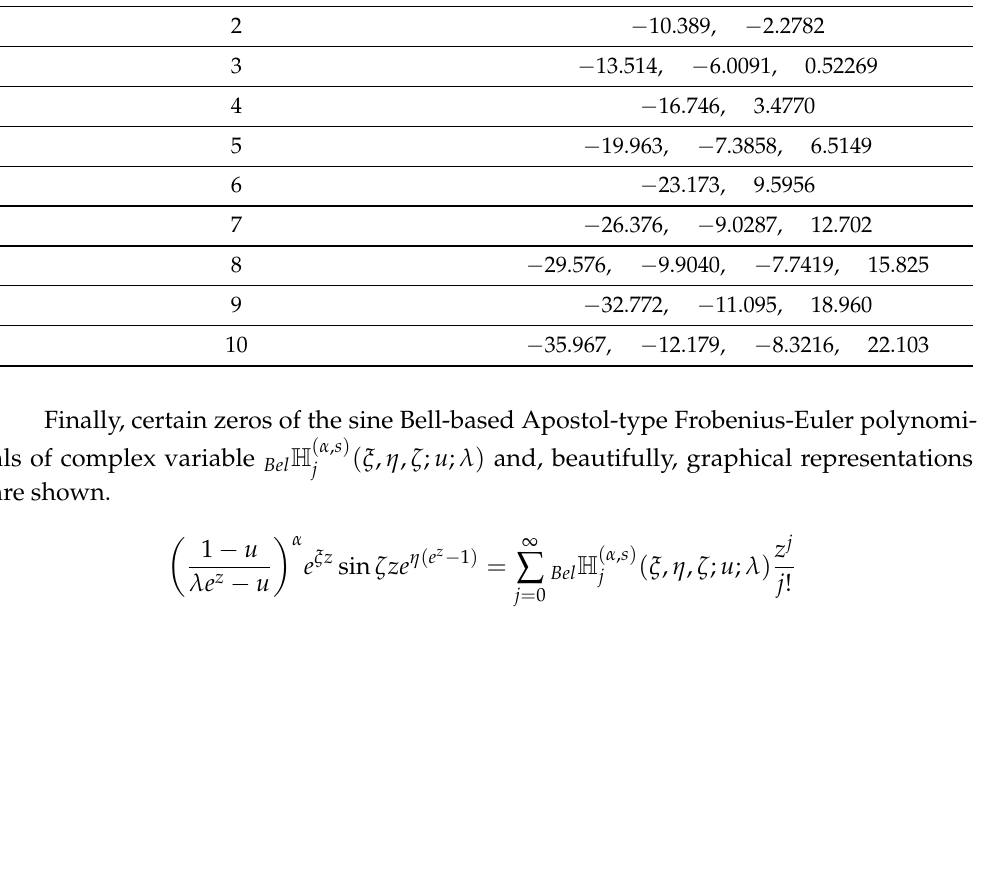
Table 2. Approximate solutions of Bel H